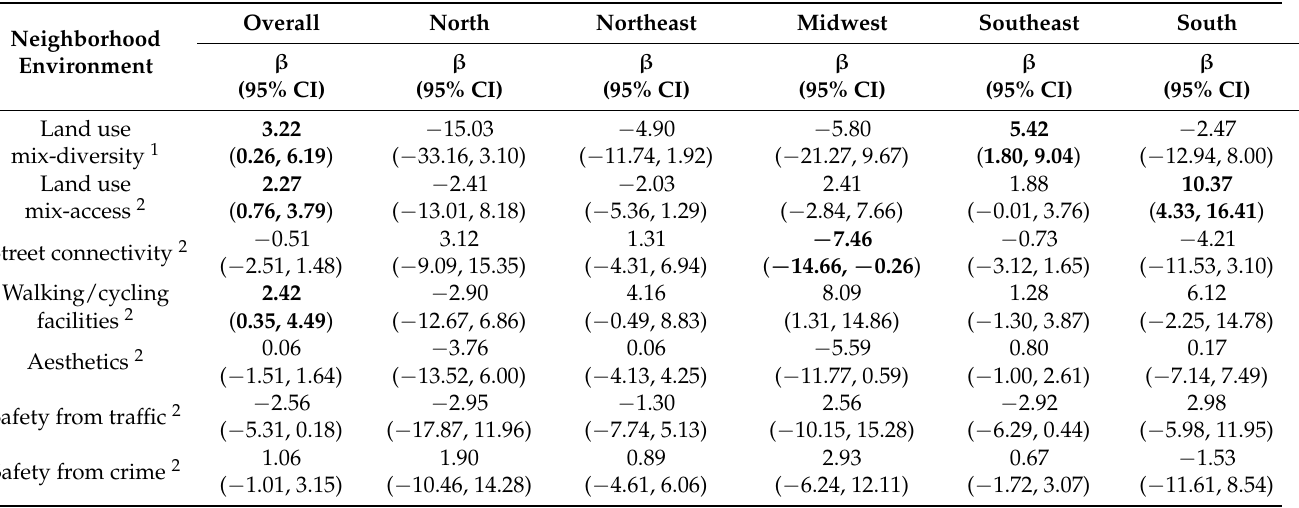
Table 4. Association ( β [95% CI]) between perceived neighborhood-built environment and leisure physical activity (min/week).